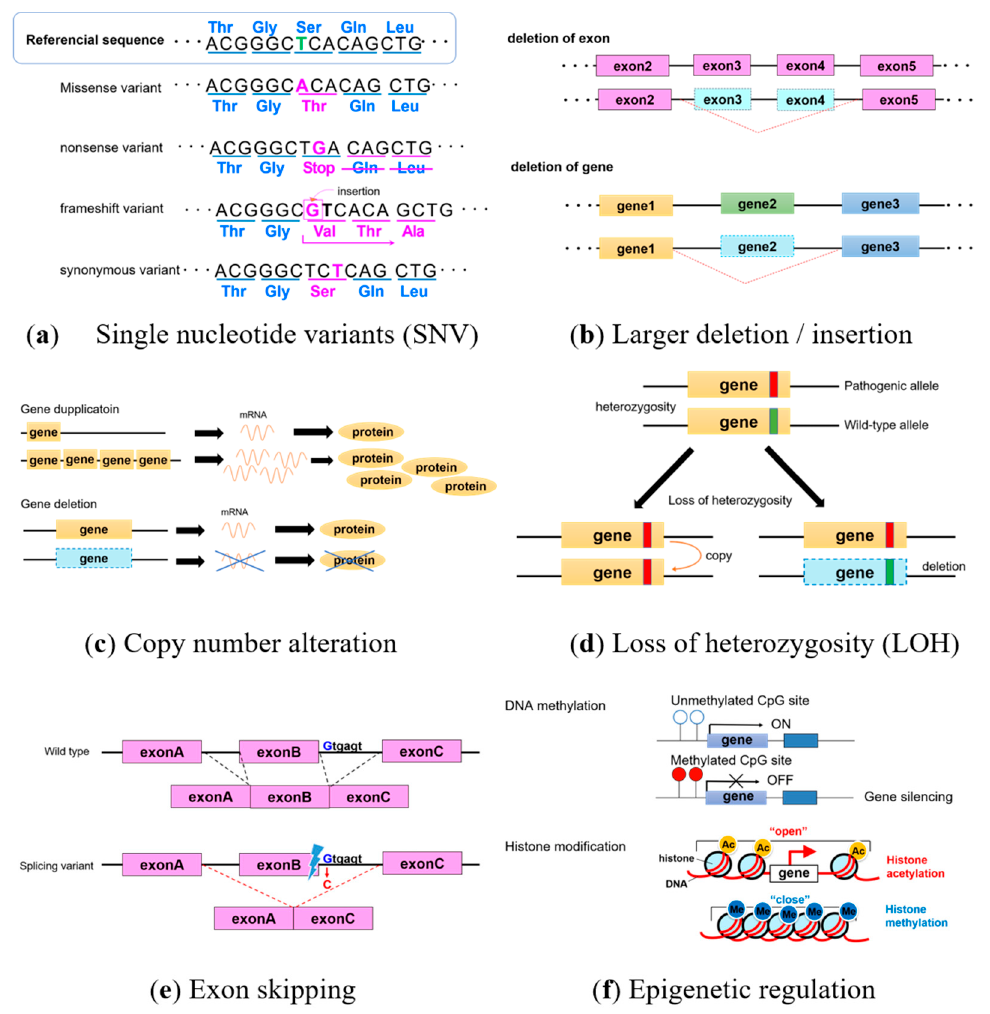
Figure 1. Genetic alterations. ( a ) Single nucleotide variants, ( b ) large deletion / insertion in exon or gene, ( c ) copy number alteration, ( d ) loss of heterozygosity, ( e ) exon skipping, and ( f ) epigenetic regulation.